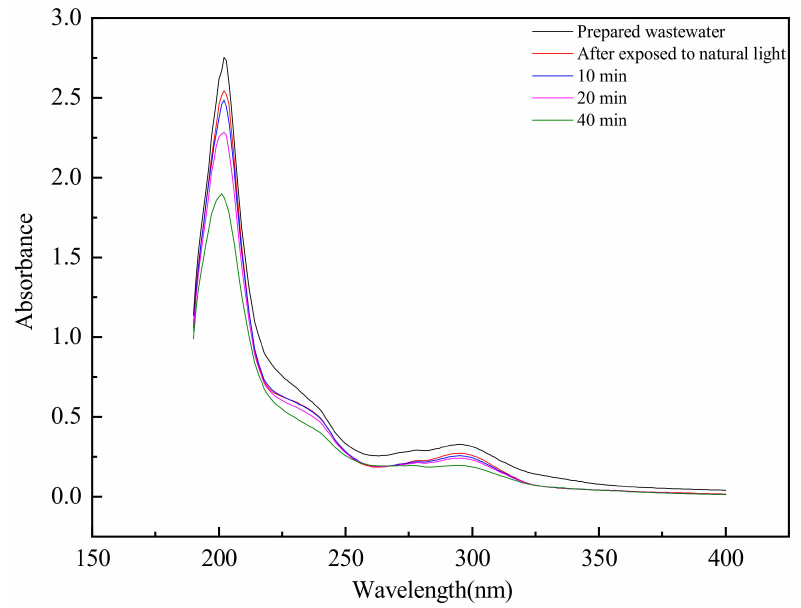
Figure 11. The ultraviolet absorption spectrum of salicylic hydroxamic acid with different ozonation times. The two characteristic absorption peaks at 296 nm and 204 nm of salicylic hydrox- amic acid decreased with the prolonged ozonation time, which showed the characteris- tic functional group of salicylic hydroxamic acid being destroyed effectively. The peak ( λ max = 296 nm) of absorption red-shifted was changed to 303 nm after 10 min ozona- tion. According to the literature, the characteristic absorption peak of salicylic acid